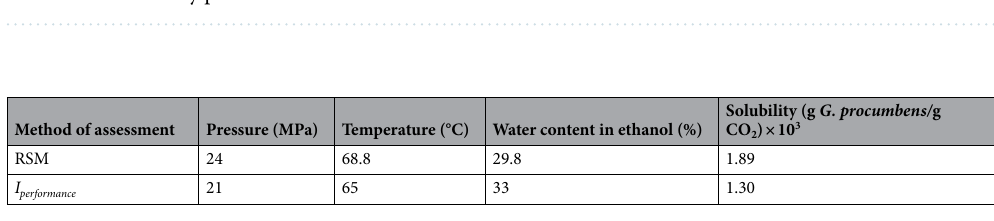
Table 10. Secondary potential scenario from the BLEVE.